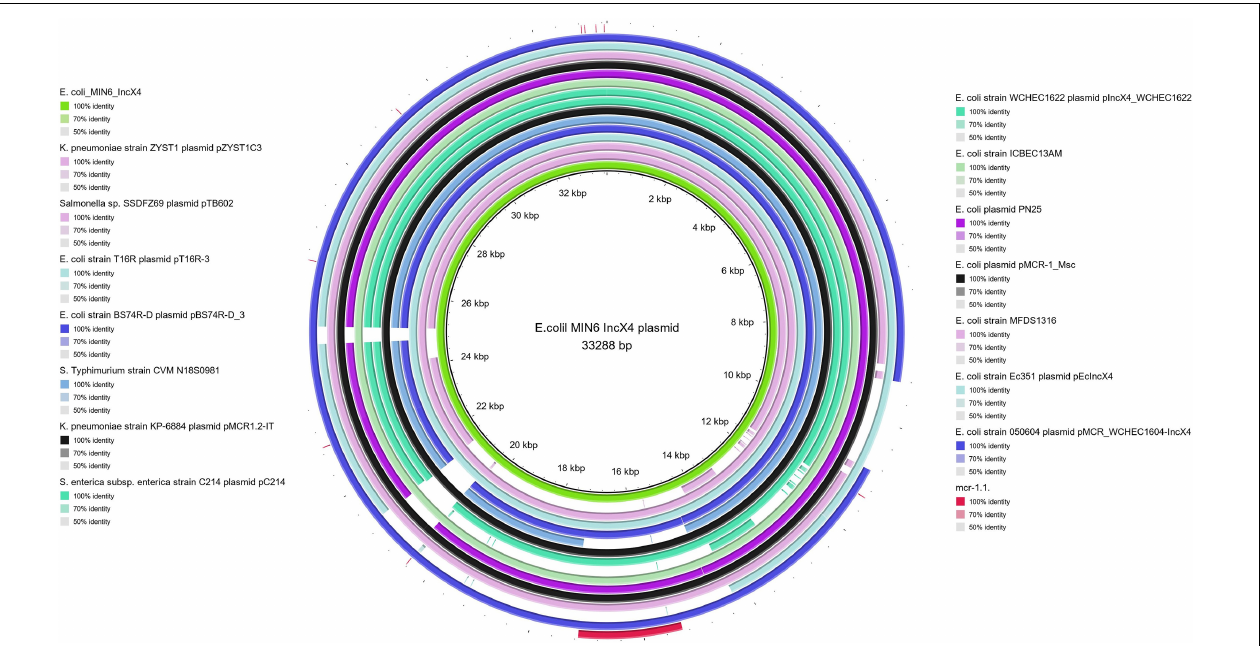
FIGURE 2 | BRIG alignment of IncX4 plasmids recovered from different Enterobacterales. Structural comparison between colistin-conferring plasmids harbored by studied extraintestinal E. coli isolates and IncX4 plasmid sequences deposited in NCBI was prepared using BLAST Ring Image Generator (BRIG). The alignment includes the mcr -1.1. sequence (red fragment), and the one IncX4 mcr-1–bearing plasmid harbored by E. coli MIN6 described in our study (green inner